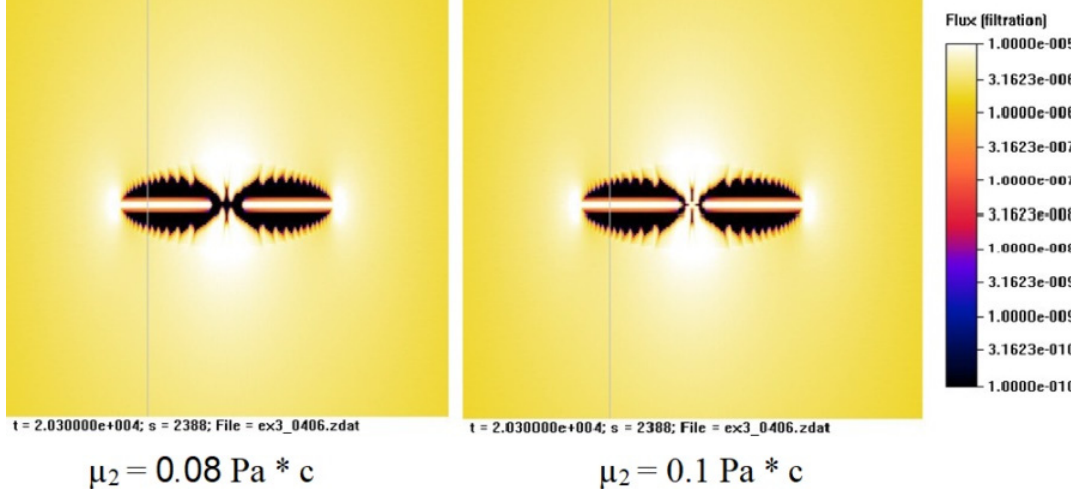
Figure 32. Oil seepage velocity approximately 5 h 38 min after the start of cleaning.